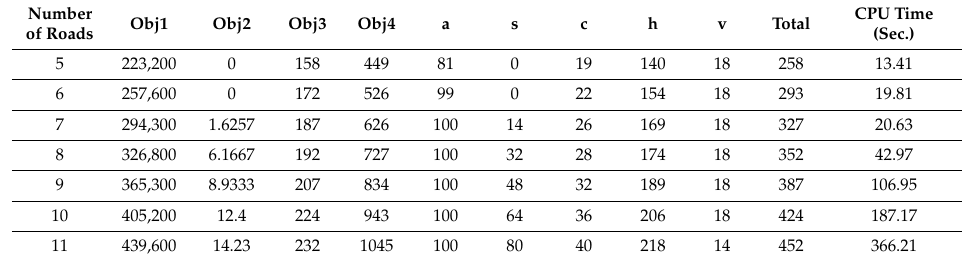
Table A2. Optimal allocation with increasing number of road segments using weighted sum method.